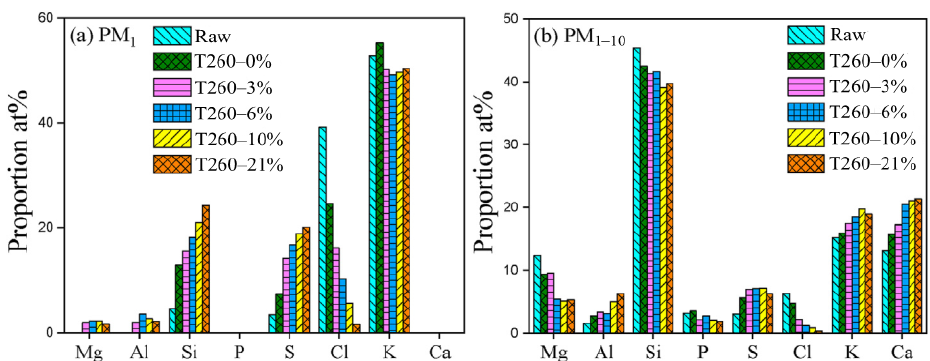
Figure 3. Chemical compositions of PM 1 and PM 1 – 10 , from the combustion of raw and torrefied cotton stalk pellets at 260 ◦ C with different oxygen content. Adapted with permission from Ref. [65]. 2022, Elsevier.